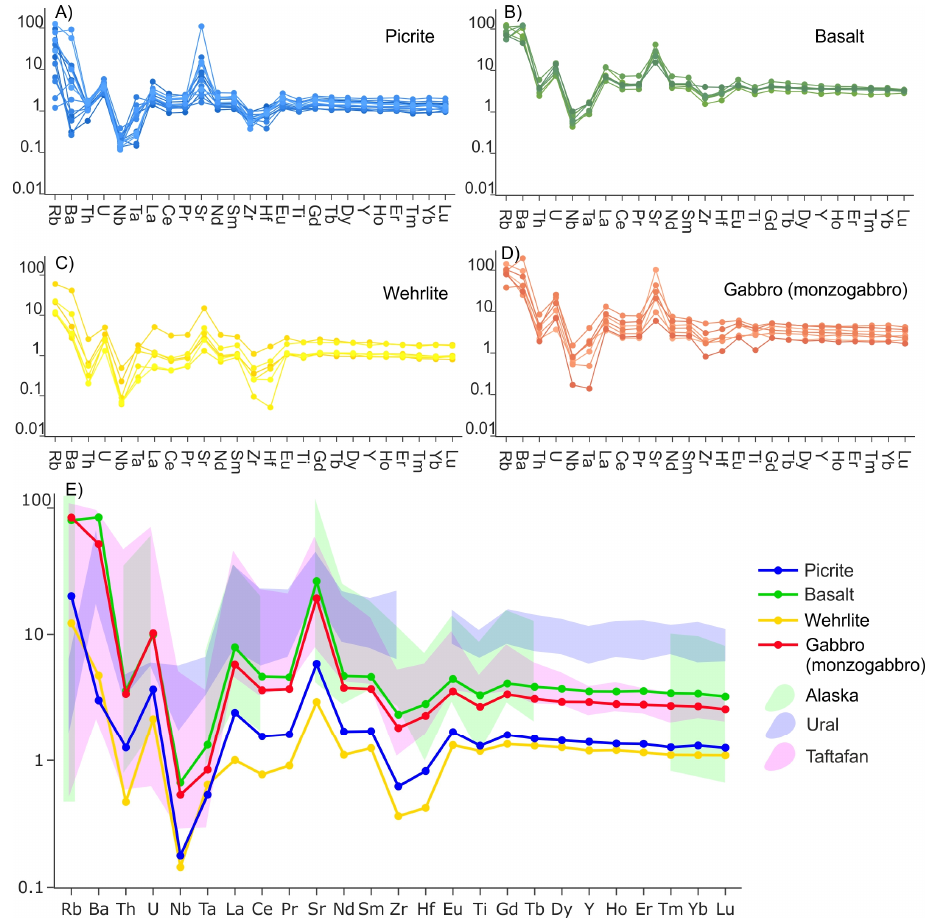
Figure 11. Trace element PM-normalized [88] spider-diagrams for the bulk-rock compositions. ( A ) Picrites (ankaramites); ( B ) basalts; ( C ) wehrlites; ( D ) gabbros (monzogabbros); ( E ) averaged compositions of the rock varieties compared to compositions of the rocks of UA-complexes worldwide. Sources of data for the comparison are in Figure 7.